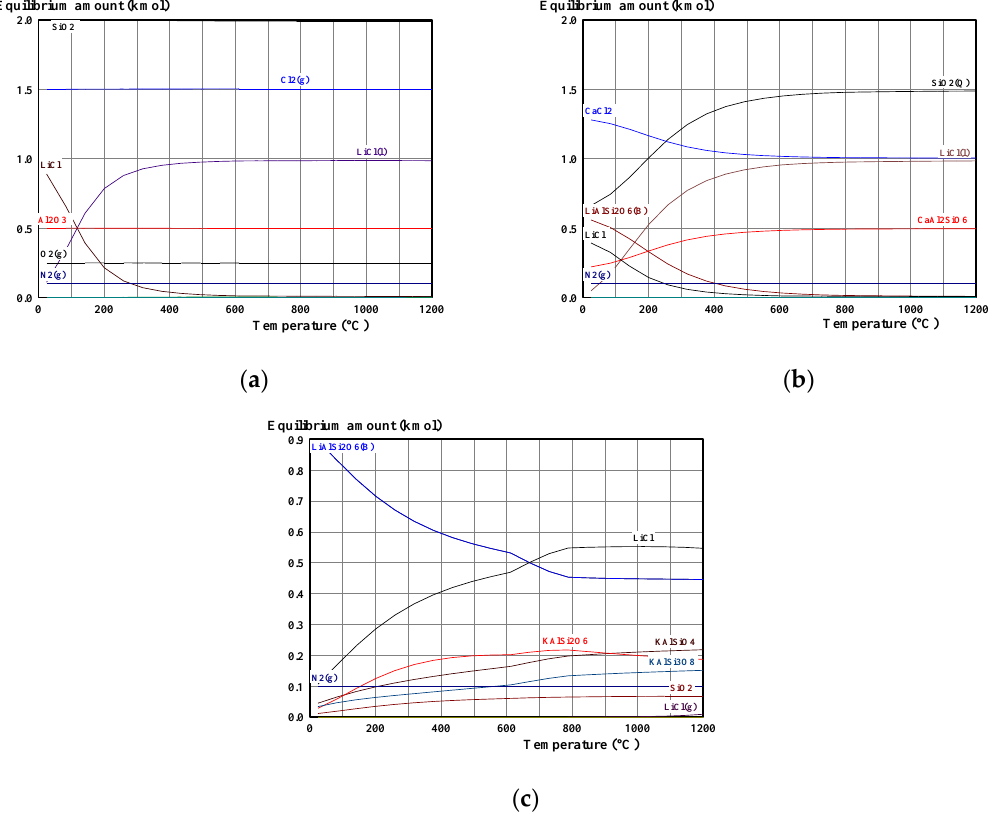
Figure 5. Equilibrium amounts versus temperature for chlorination of spodumene using ( a ) CaCl 2 , ( b ) Cl 2 and ( c ) KCl (data from HSC Chemistry 5.1 software).